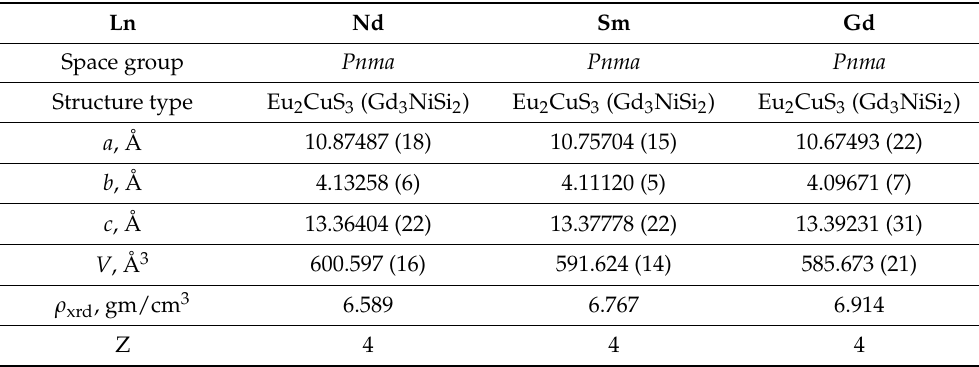
Figure 3. XRPD patterns of EuLnCuSe 3 compounds (the sample annealed at 1073 K). Table 2. Unit cell parameters of EuLnCuSe 3 compounds (the sample annealed at 1073 K). Ln Nd Sm Gd Space group Pnma Pnma Pnma